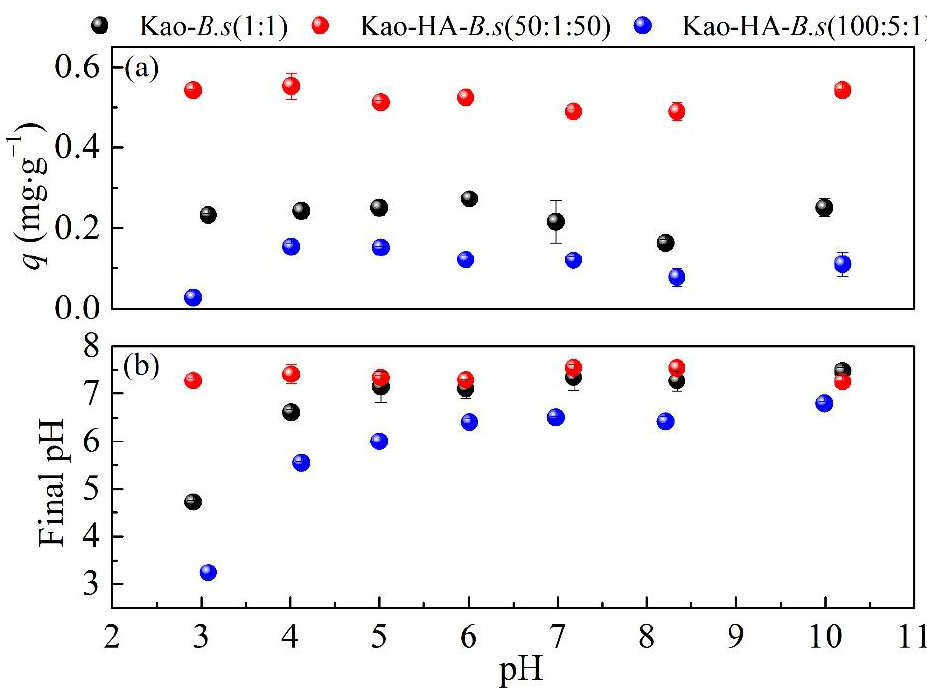
Figure 1. Effect of pH on As(V) adsorption onto kaolinite composites: ( a ) pH & q; ( b ) pH initial & pH final (C 0 : 2.5 mg · L − 1 ; adsorbent dosage: 2.5 mg · L − 1 ; T: 25 ◦ C; Ionic strength: 0.01 mol · L − 1 ; t: 24 h).